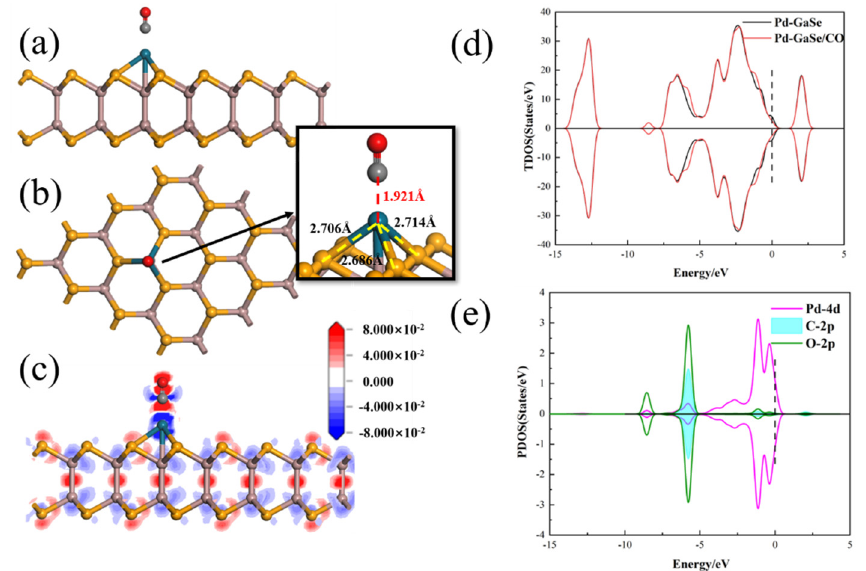
Figure 9. Adsorptive structure of Pd-GaSe/CO system ( a ) view of side, ( b ) view of top, ( c ) DCD distribution, ( d ) TDOS of Pd-GaSe/CO system, ( e ) PDOS of Pd-GaSe/CO system.